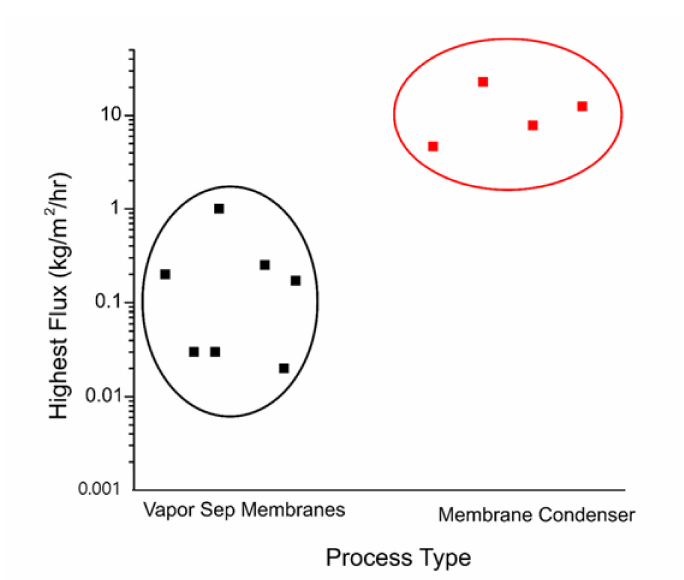
Figure 8. Comparison of membrane-based dehydration processes. Vapor separation membranes are polymeric and TMC membranes are